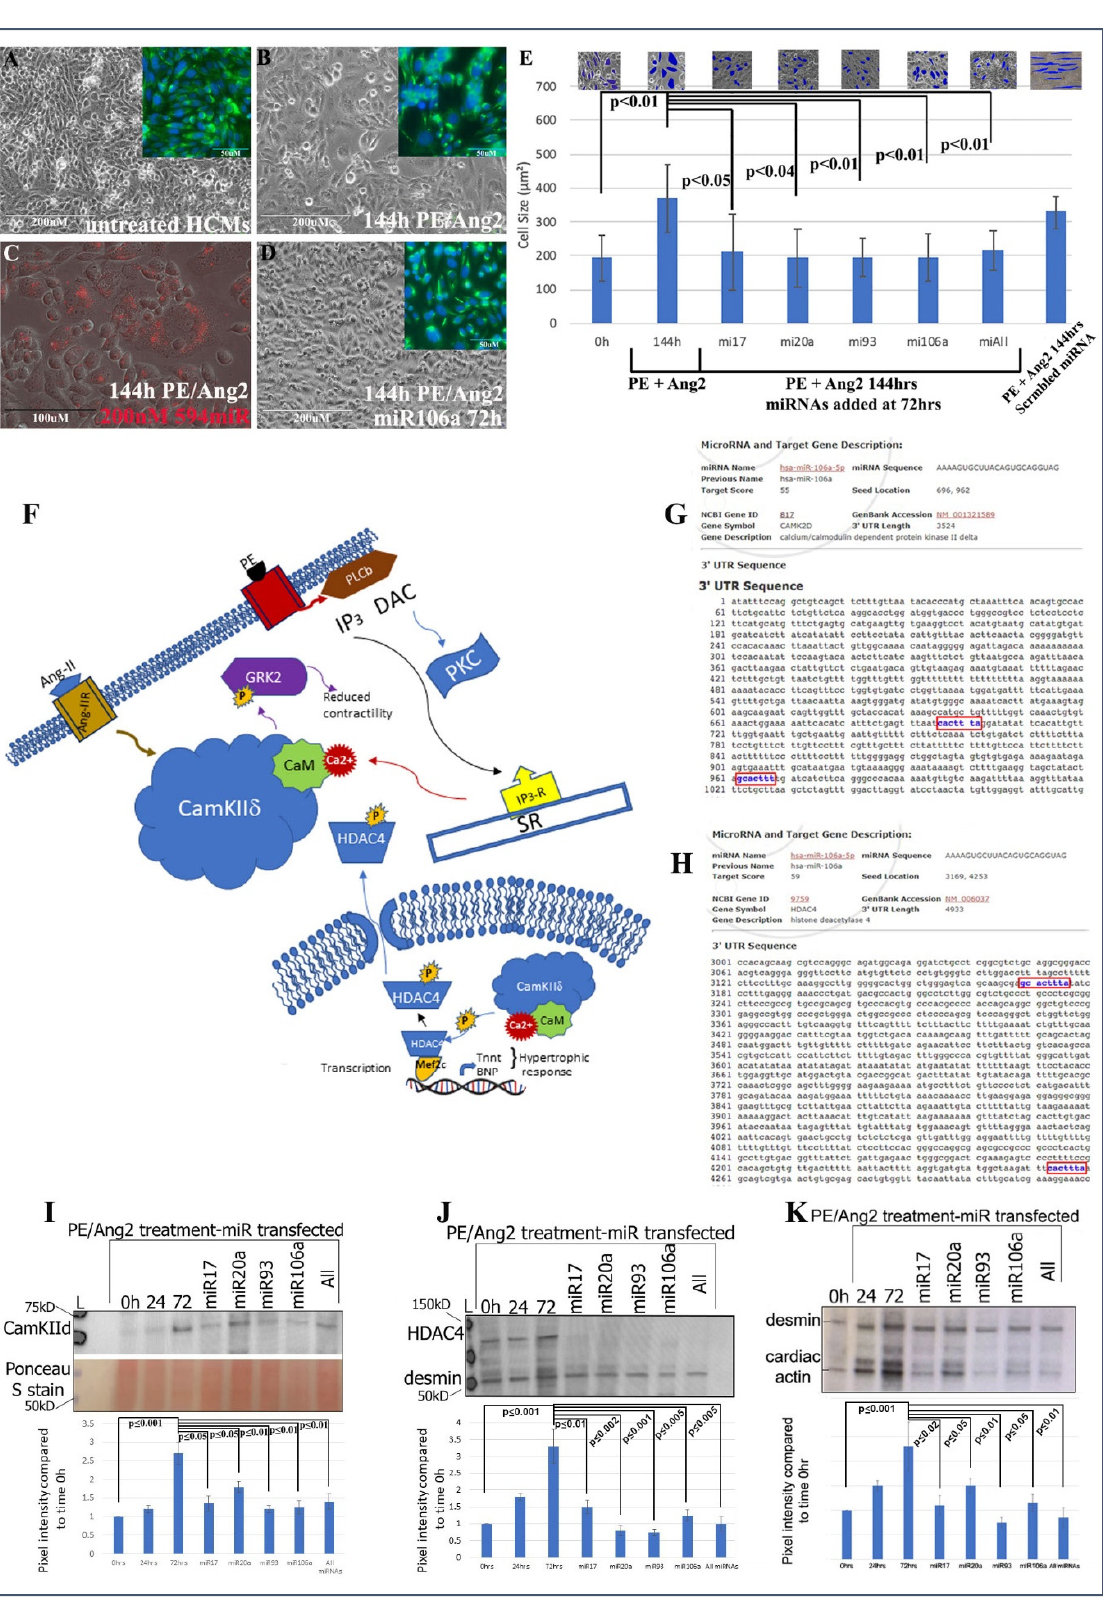
Figure 1. Treating cardiomyocytes with PE and Ang II causes hypertrophy, while treating hyper- trophic cells with miRNAs reverts hypertrophic HCMs back to normal size. ( A ) Microscopic images of untreated HCMs. ( B ) HCMs treated with PE/AngII and ( D ) HCMs treated with PE/AngII, fol- lowed by miRNA106a. Insets in ( A , B , D ) show anti-desmin (cardiac) staining in same cells. ( C ) Con- trol using a fluorescently tagged miRNA shows transfection efficiency is ~90%. The size of the cells